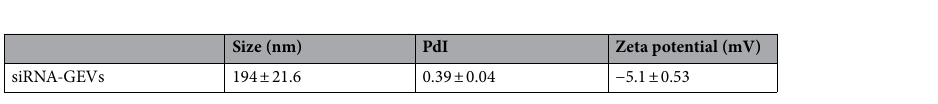
Table 3. Physicochemical properties of siRNA-GEVs. The results were expressed as the mean ± S.D. (n = 4).